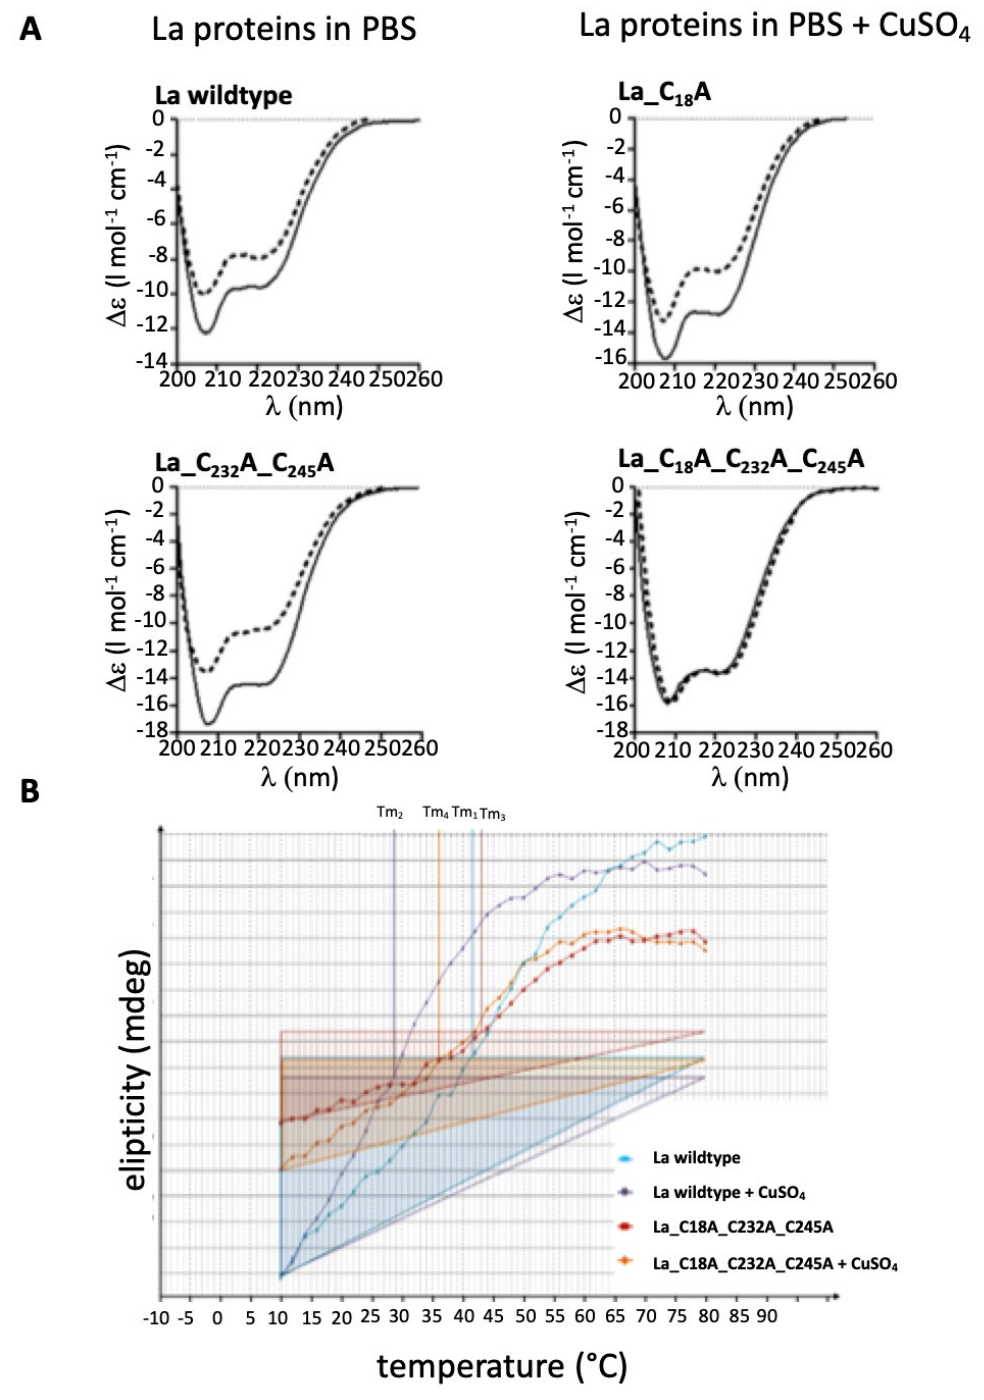
Figure 11. Circular dichroism (CD) analysis. ( A ) CD spectra were prepared for wild-type La protein (La wild-type), the mono (La_C 18 A), double (La_C 232 A_C 245 A), and triple cysteine (La_C 18 A_C 232 A_C 245 A) mutant, including under oxidative conditions. ( B ) Estimation of the melting temperature of La wild-type and the triple cysteine mutant (La_C 18 A_C 232 A_C 245 A) in the absence or presence of 90 µ M CuSO 4 . The protein concentration of each sample was 0.2 mg/mL. CD spectra were collected in the temperature range between 10 ◦ C and 80 ◦ C. Each step represents a difference of 2.5 ◦ C.